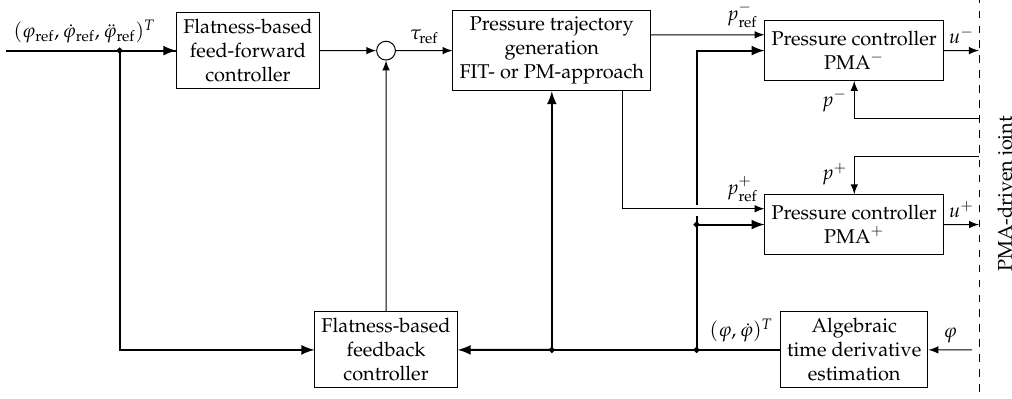
Figure 9. Flatness-based control architecture to stabilize the angle